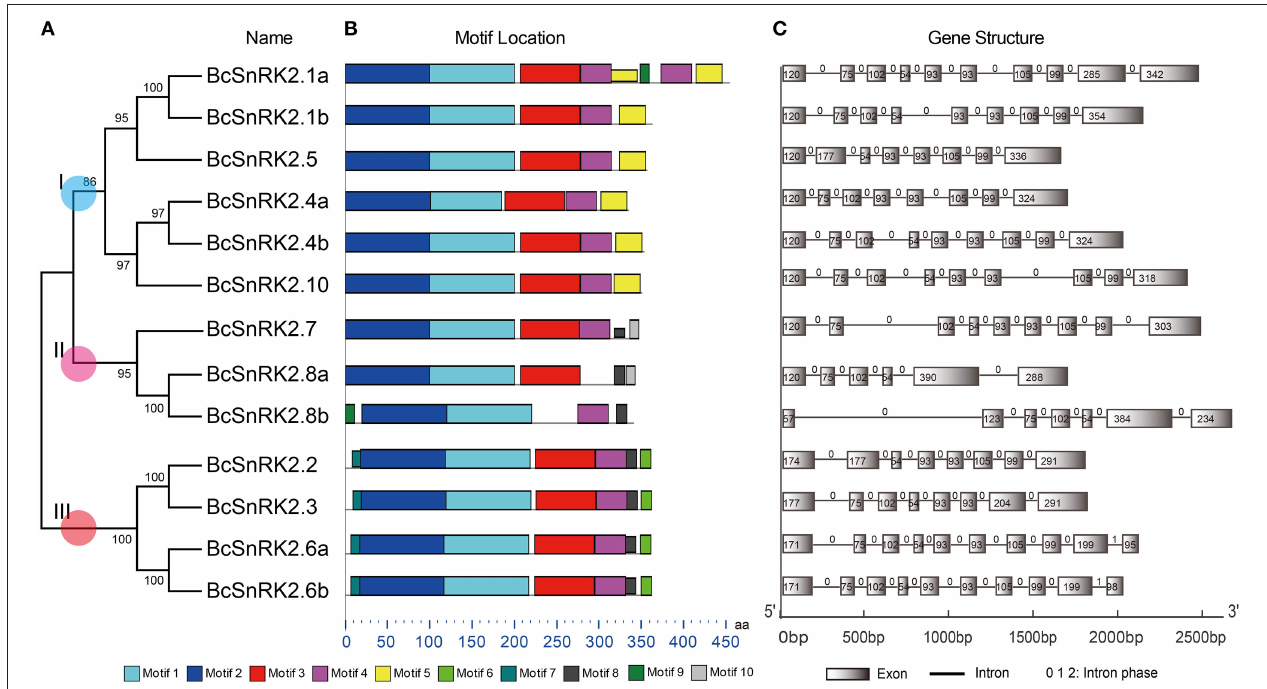
FIGURE 4 | Diagrammatic structure of BcSnRK2 genes. (A) The unrooted phylogenetic tree resulting from the full-length amino acid alignment of all of the BcSnRK2 proteins in Pak-choi. The tree was constructed using maximum likelihood (ML) and bootstrap values calculated with 1000 replications using MEGA5 ( Tamura et al., 2011). (B) The distribution of the conserved motifs in the SnRK2 genes from Pak-choi identified using MEME tool. The length of bars indicate the length of BcSnRK2 proteins. (C) Exons and introns of the BcSnRK2 genes. Each motif is represented by a number in the colored box. Introns and exons are represented by black lines and boxes, respectively. The numbers above the introns indicate intron phase. The numbers in the exons indicate the length of the exons. The length of bars indicate the length of BcSnRK2 genes.